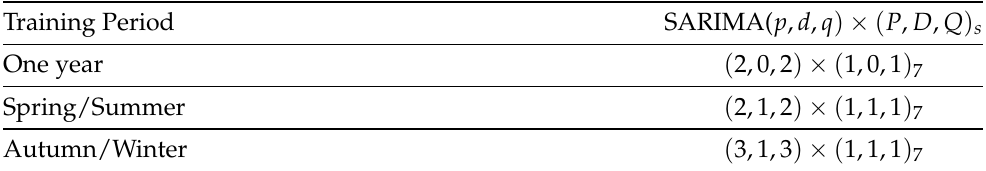
Table 1. SARIMA model’s